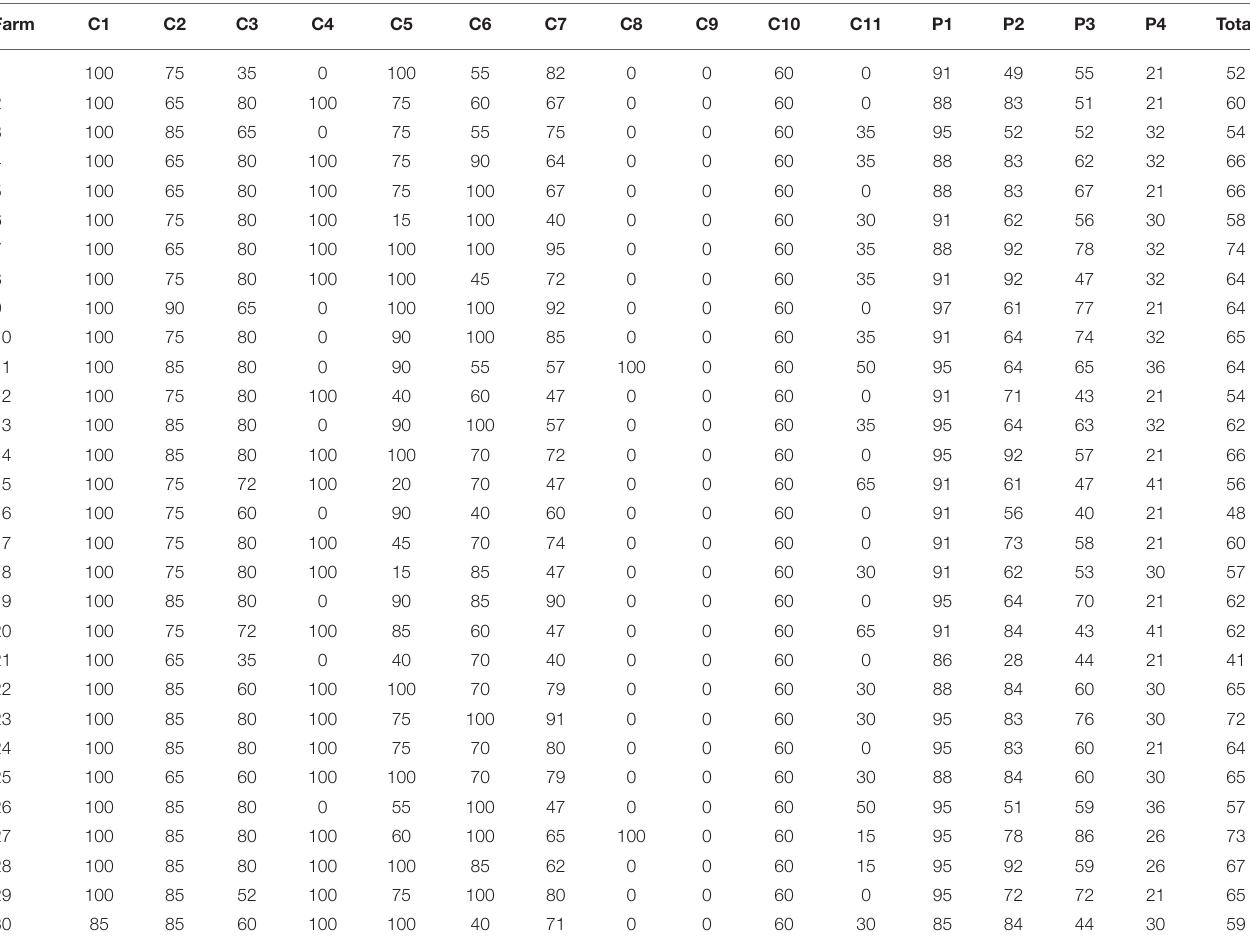
TABLE 6 | Score obtained (from 0 to 100 points) for the different criteria (C1: Absence of prolonged hunger; C2: Absence of prolonged thirst; C3: Comfort around resting; C4: Thermal comfort; C5: Ease of movement; C6: Absence of injuries; C7: Absence of diseases; C8: Pain induced by management; C9: Social behavior; C10: Other behaviors; C11: Human-animal relationship), for the different principles (P1: Good feeding; P2: Good housing; P3: Good health; P4: Appropriate behavior) and the overall score as the result of the combination of the scores of the 4 principles (TOTAL) by farm (from 1 to